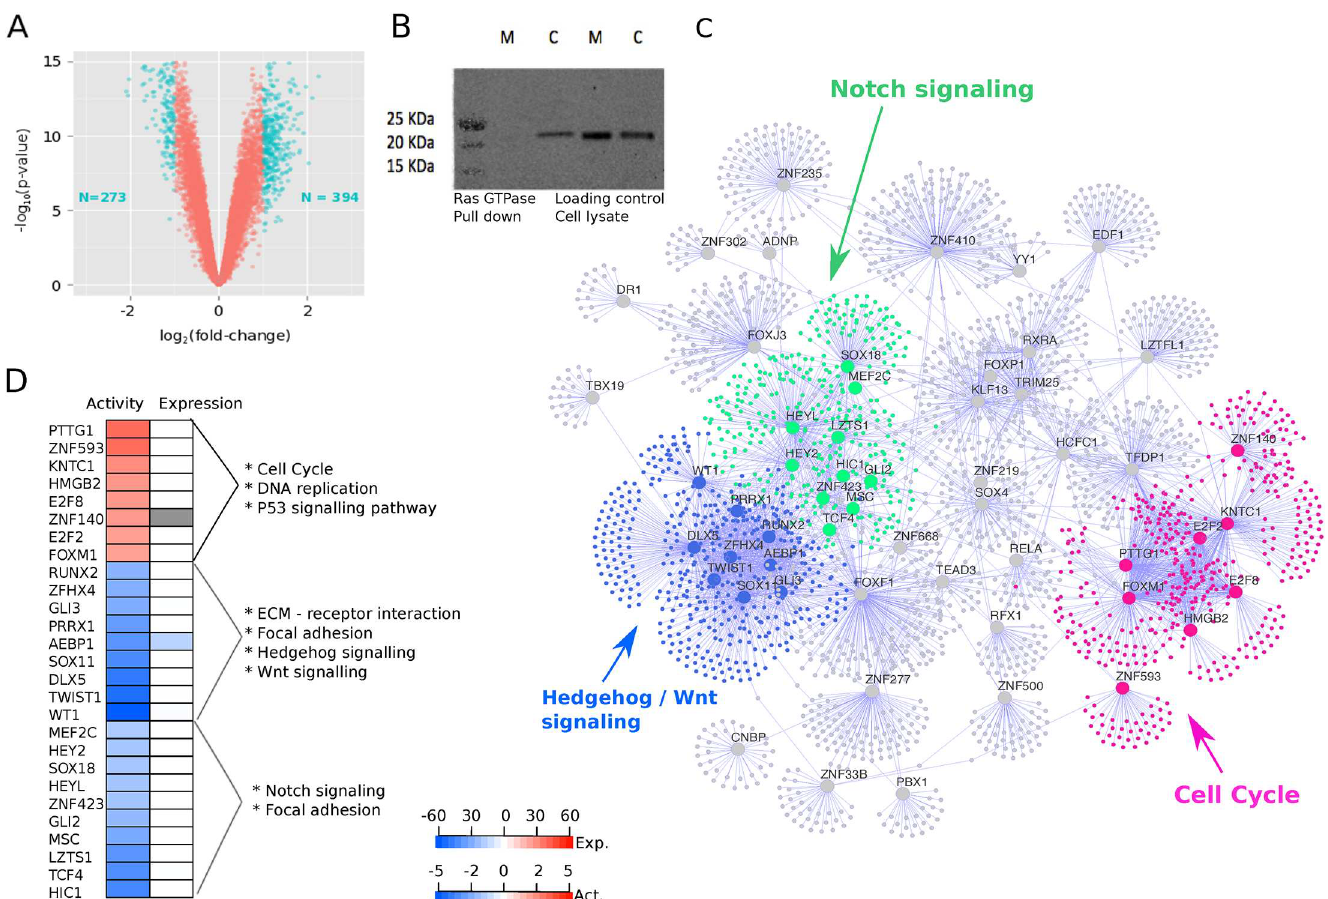
Fig 1. Oncogenic KRAS is regulated by three groups of master regulators. A. Volcanoplot showingthe magnitude of the differentialgene expression betweenmurinemock ductal cells and murine cre ductal cells (with activated oncogenic Kras ). Each dot representsone probe with detectableexpression in both conditions.The coloureddots mark the threshold( p < 0.05 and log2 fold-change > 1) for defininga gene as differentiallyexpressed. B. Ras GTPase assay shows increasedGTPase activity in cre cells blotted with pan-Rasantibody (M, mock; c, cre). C. Visual representation of master regulators (MRs) identified with msVIPER analysis( p < 0.01). The nodes in the networksrepresent the 55 master regulators(large dots) and the corresponding inferred targets (smaller dots). The edges in the network represent the regulatoryrelationship betweenregulatorsand the inferred targets. The colours highlightthe community structure of the network identifiedvia greedyoptimizationof modularity. The three groupsof nodes correspond to a total of 27 master regulatorsand represent three distinct diseaseprocesses enrichedfor cell cycle (pink), Hedgehog/Wnt signalling (blue), and Notch signalling (green)pathways. D. For the 27 MRs in the three core processes, the heat map shows their activity (first column)and differentialexpressionin the KRAS signature (second column)as obtainedby Virtual Inferenceof Protein-activity by EnrichedRegulon(VIPER) analysis.“Expression”refers to the differential expressionvalue after KRAS induction(cell line experiment). The colour code of in the heat map correspondsto the t-statistic value obtainedafter limma differential expressionanalysis, with blue representingdown-regulated genes and red representingup-regulated genesafter KRAS activation. “Activity” refers to the differentialprotein activity value after KRAS inductionwith red or blue representing activationor inactivation, respectively.The protein activity score is quantitatively inferred by the aREA algorithmin VIPER by systematically analysingexpressionof genescoexpressedwith the transcription factor